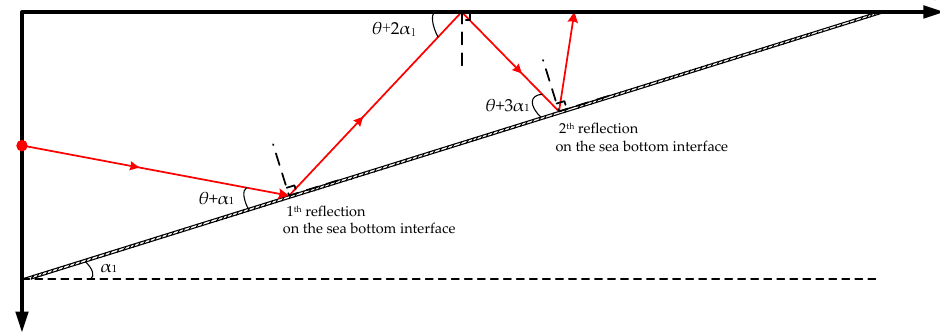
Figure 6. Distribution of the ray tracing when acoustic signals propagate in a shallow water environment with wedge- shaped uphill sea bottom, and the uphill slope angle of the wedge-shaped bottom is α 1 . According to normal mode method, under the simulation conditions in Figure 2a, nine orders of normal modes would be excited in the shallow water waveguide at 100 Hz,